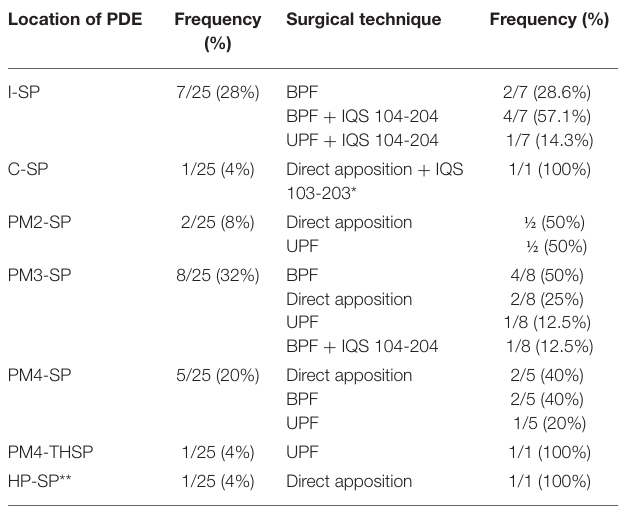
TABLE 2 | Extent of the acquired midline PDE and